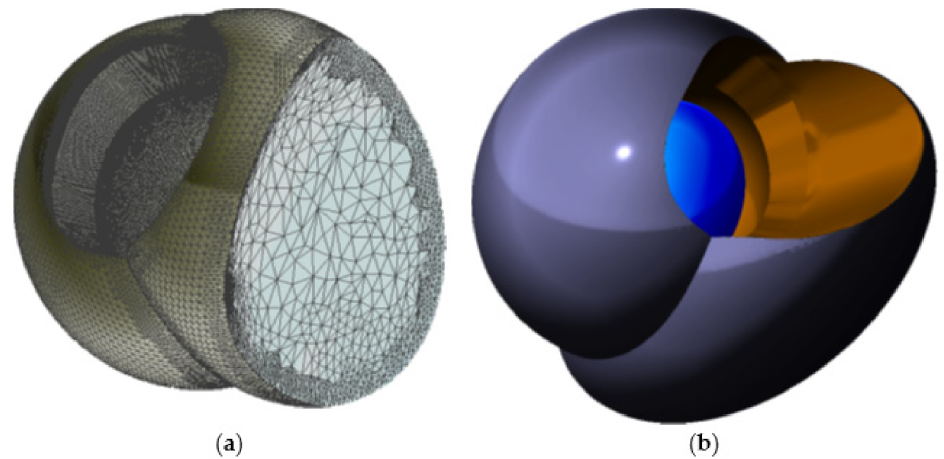
Figure 10. Vestibular and lingual side of the molar part of distalizer. ( a ) Wireframe appearance of the individual base that matches the tooth surface in the exact area that is helping in the exact positioning. ( b ) The tunnel that leads to the socket with a visible hiatus—a small circular step that is causing a “click-in” function, where slight pressure is necessary to “click-in” the arm of the distalizer with a spherical joint into the socket—both parts of distalizer shall be connected before